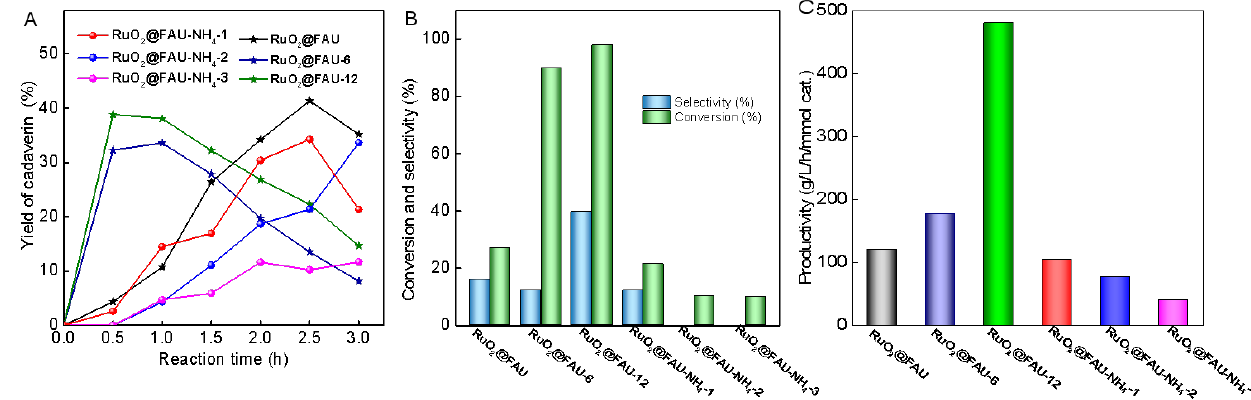
Figure 5. Decarboxylation of L-lysine to cadaverine with different catalysts. ( A ) variation of cadaverine yield with reaction time ( B ) conversion and cadaverine selectivity at 0.5 h with different catalysts, and ( C ) productivity of cadaverine with different catalysts. Reaction conditions are as follows: L-lysine (0.1 M), Ru catalysts (0.101 g), 200 °C, 800 rpm, 2 MPa H 2 , pH 2.0.